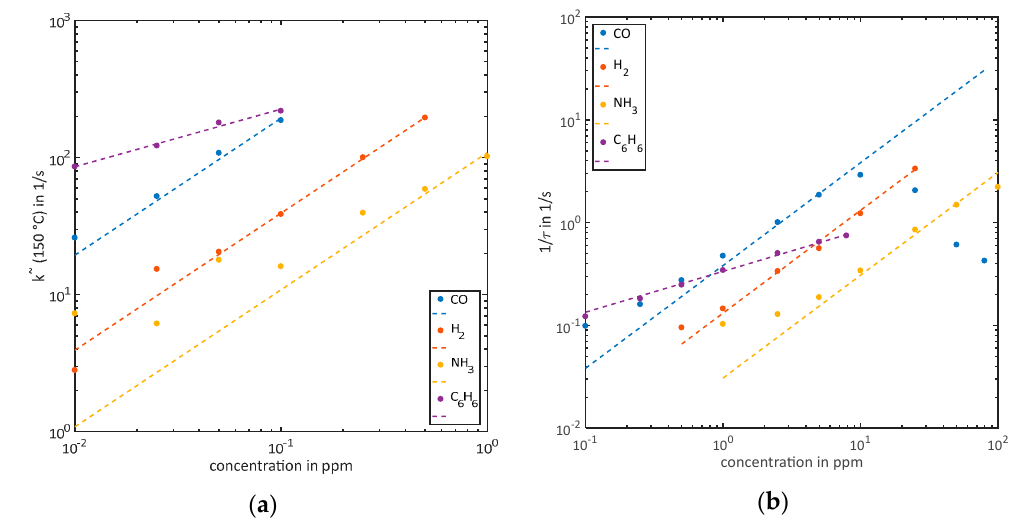
Figure 6. The results from Section 3.2 on a double logarithmic scale and for all gases in one graph: ( a ) (cid:101) k -evaluation for low concentrations showing the very high response of benzene compared to the other gases; ( b ) τ -evaluation for the higher concentrations, here the response of benzene is below the others because of the different correlation between concentration and sensor